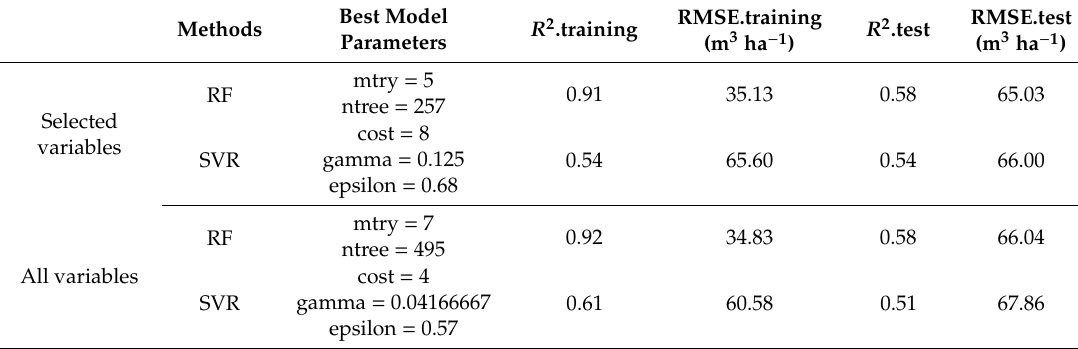
Table 6. The performance comparison of machine learning methods under di ff erent